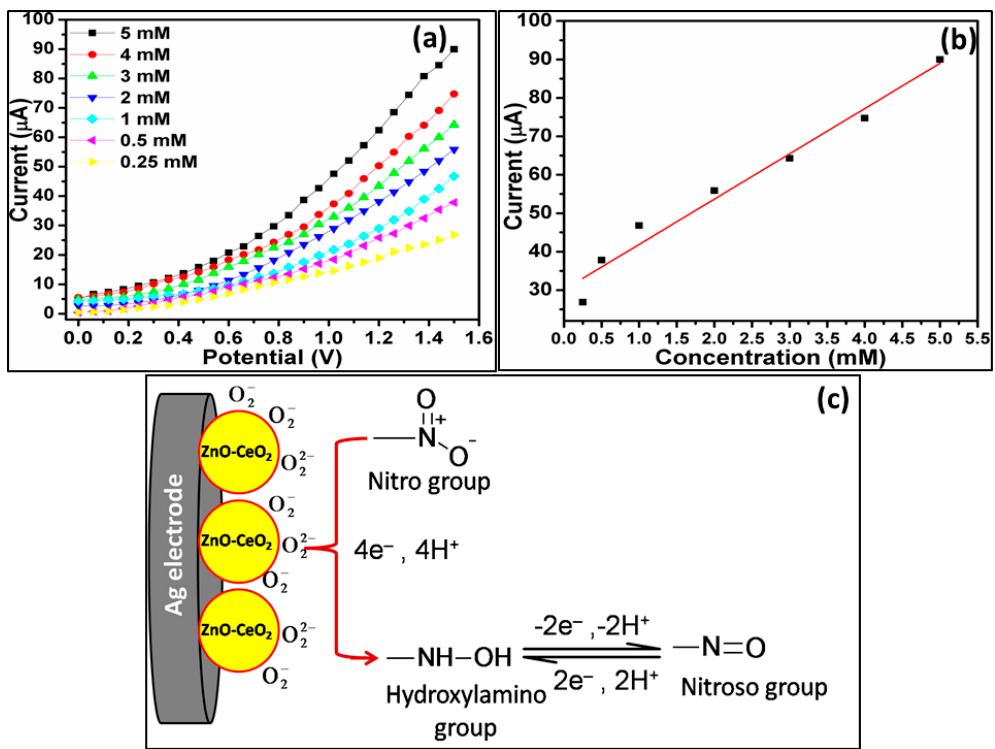
Figure 4. ( a ) Current-voltage responses for various concentrations of nitroaniline; and ( b ) Calibration curve for nitroaniline using ZnO-doped CeO 2 nanoparticles-modified silver electrode (AgE); ( c ) A proposed sensing mechanism for the ZnO-doped CeO 2 nanoparticles-modified AgE toward nitroaniline sensing. Adapted figure from [69] with permission from copyright (2016), Elsevier.